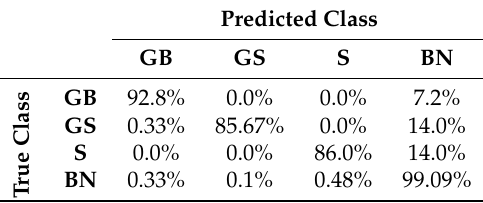
Table 4. Results achieved by our multi-headed 2D CNN applied to the data-base collected in